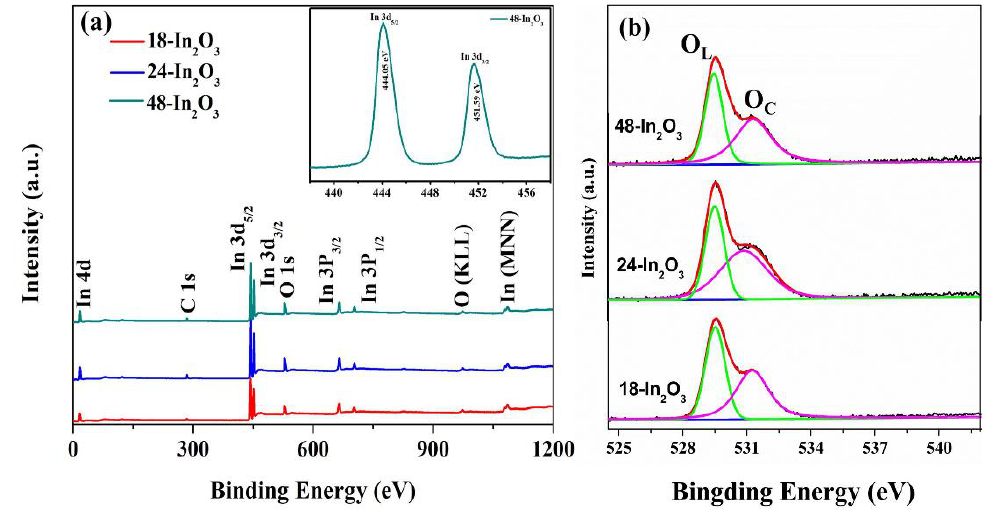
Figure 8. XPS spectrum of the porous In 2 O 3 samples: ( a ) survey (the inset is an In 3d spectrum of the 48-In 2 O 3 ) and ( b ) O 1 s. Table 3. Comparison of the adsorbed oxygen content and gas sensitivity of the In 2 O 3 samples.